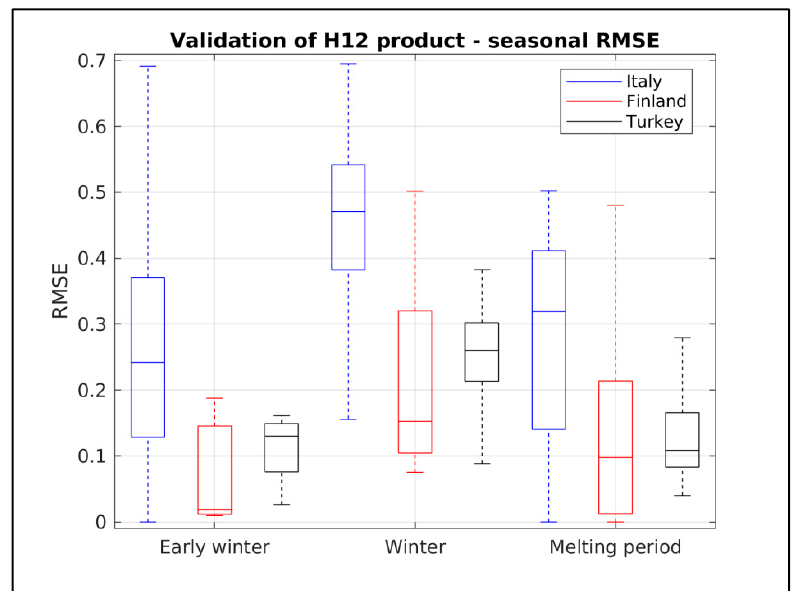
Figure 18. Seasonal RMSE in Italy, Finland, and Turkey. Table 12. Overall RMSE values for the comparison between S-2-derived FSC maps and H12 product. H12 product requirement for both flat (i.e., Finland) and mountainous areas (i.e., Italian Alps, Turkey) (RMSE thr ) is reported